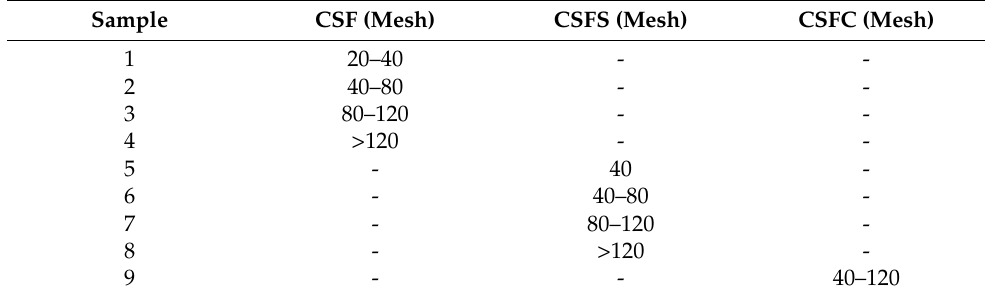
Table 2. CSF with different components and particle sizes.